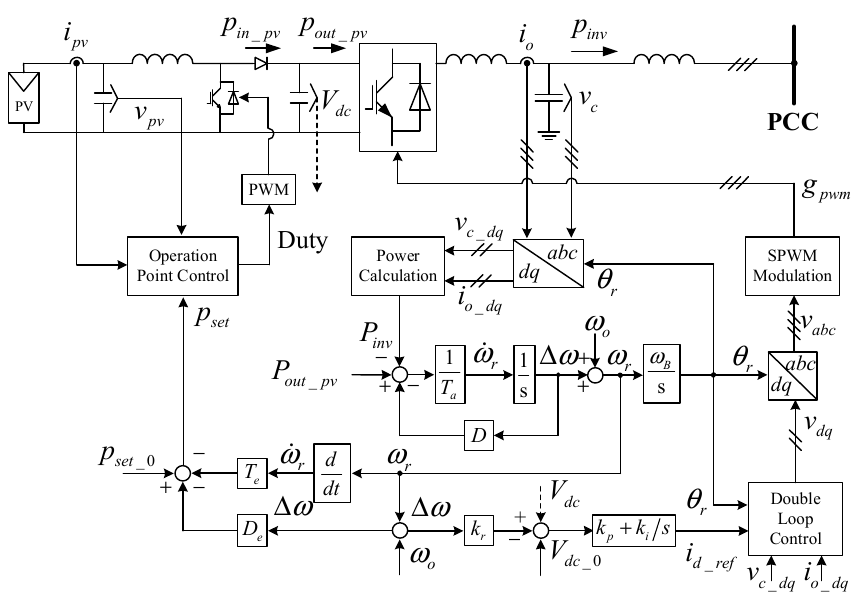
Figure 7. Implementation of the proposed VIFC strategy.